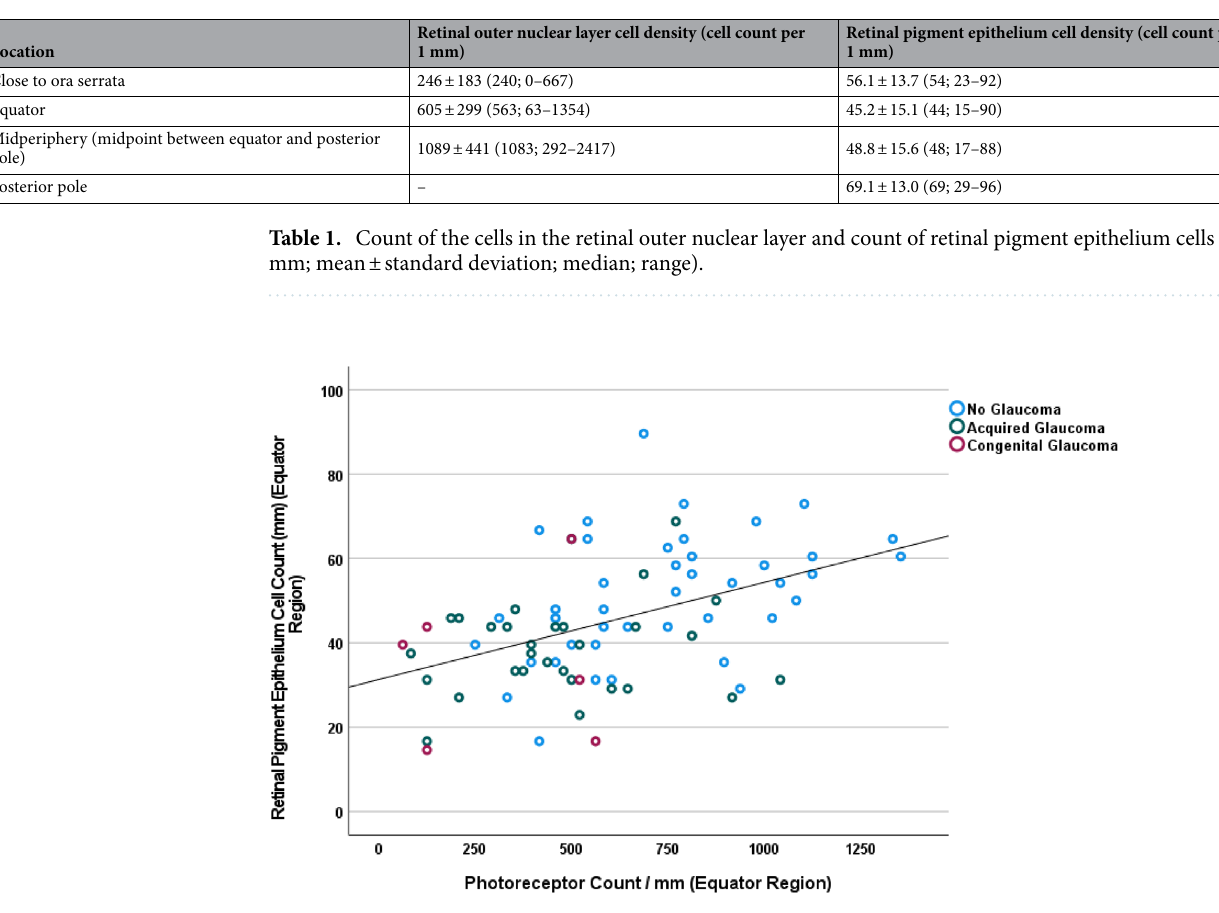
Figure 2. Scattergram showing the distribution of the retinal pigment epithelium cell density at the equator in relationship to the retinal photoreceptor density at the